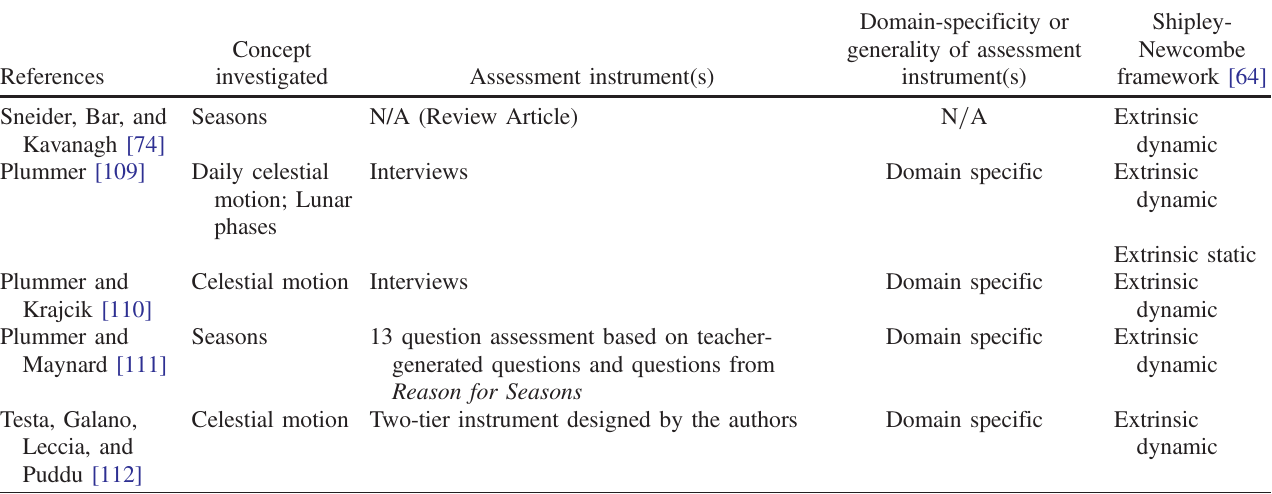
TABLE IX. Newcombe-Shipley [64] categories for learning